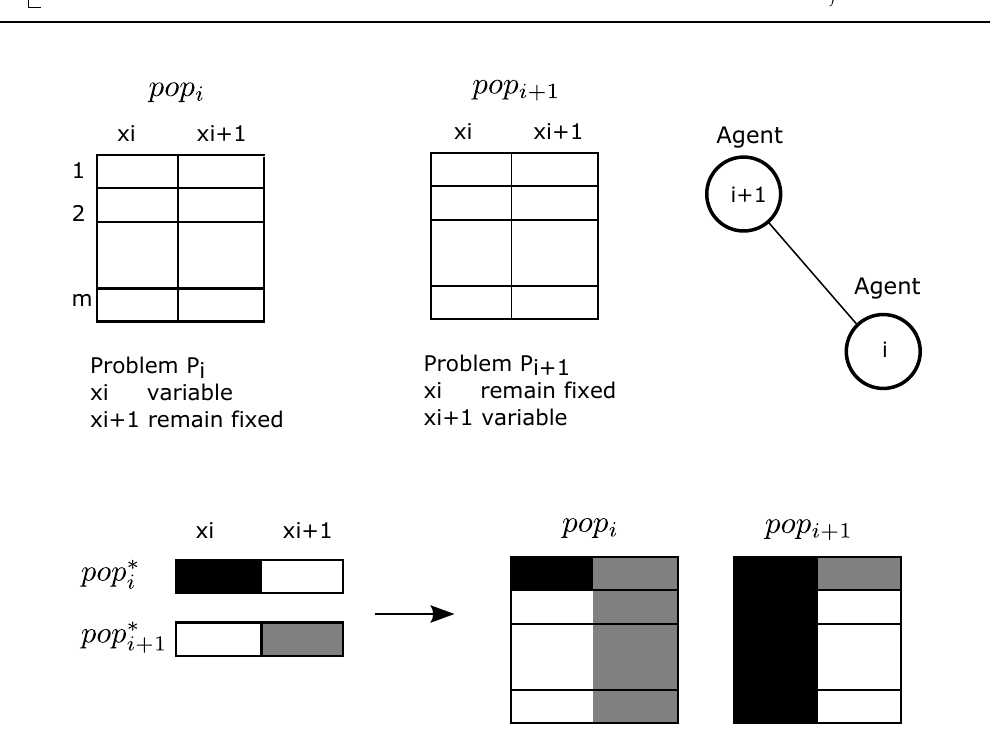
Figure 2. Exchanging the best individual values within the the neighbouring populations at the end of each generation for ne i = 2. x ∗ is fixed in pop i + 1 and x ∗ is fixed in pop i in each i i + 1